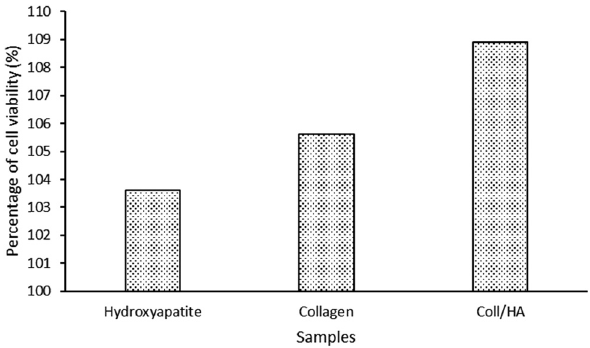
Figure 9: MTT assay of